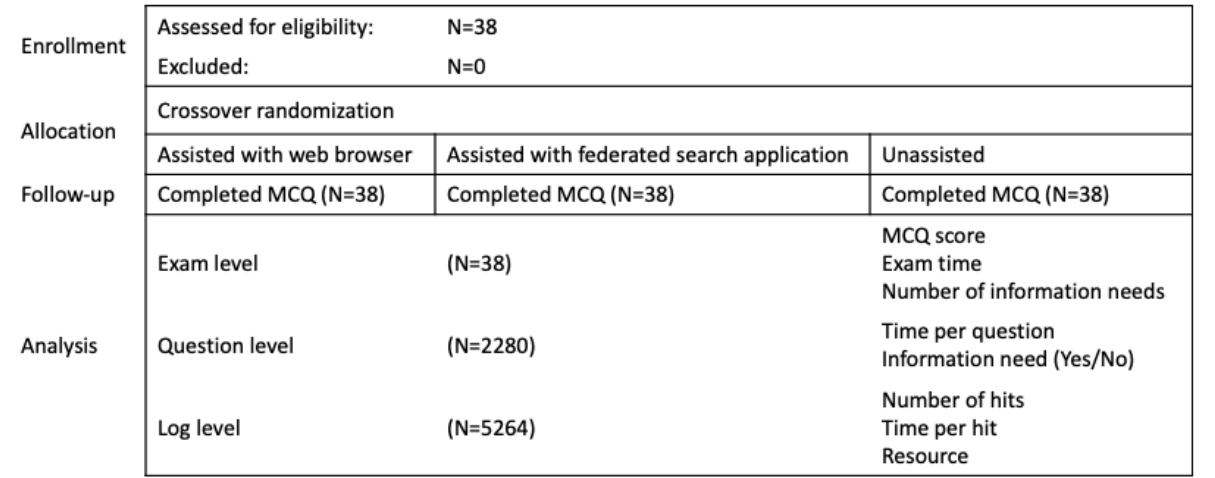
Figure 3. CONSORT (Consolidated Standards of Reporting Trials) diagram of the study design. Note that information needs were considered in the assisted conditions only. MCQ: multiple-choice